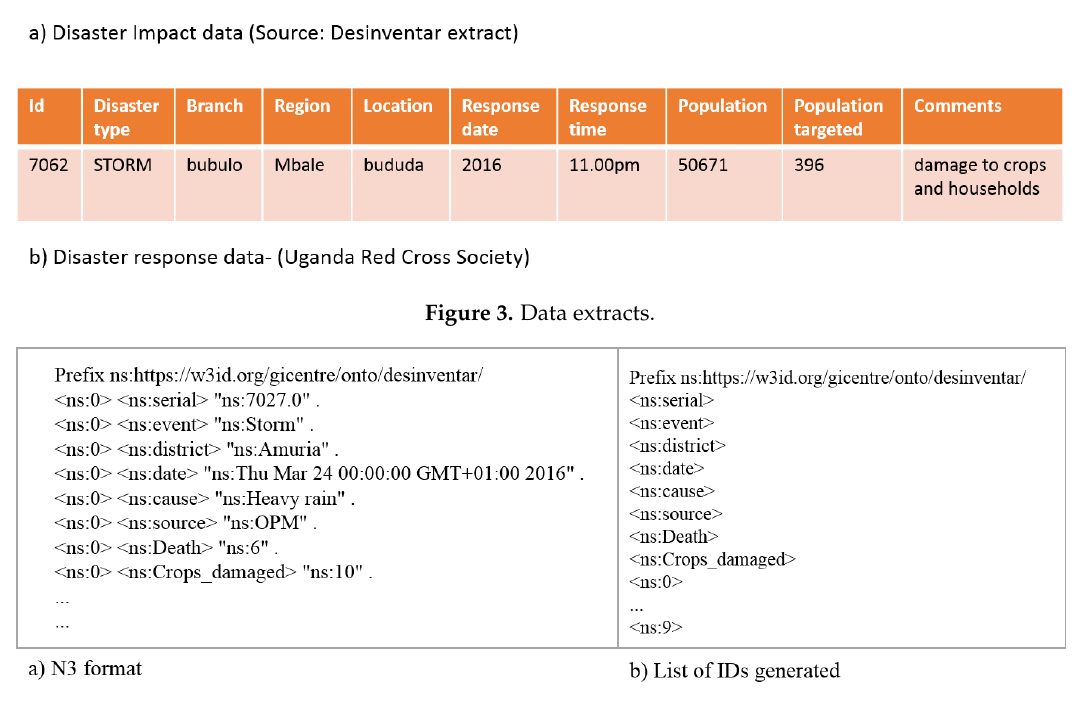
Figure 4. NTriple (N3) and ID generation from datasets in Figure